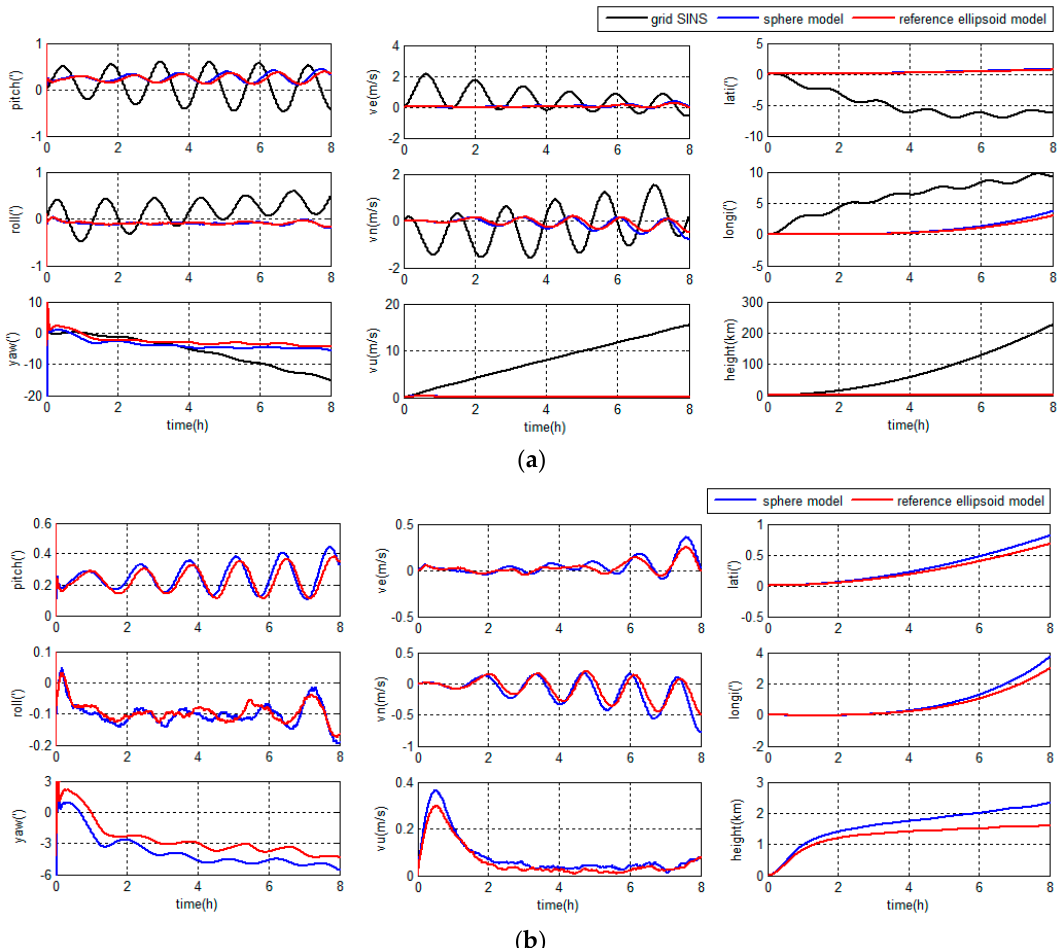
Figure 8. Navigation errors in middle latitude regions: ( a ) grid strapdown inertial navigation system (SINS) errors and integrated navigation errors; and ( b ) integrated navigation errors. Table 1. Integrated navigation position errors in the middle latitude